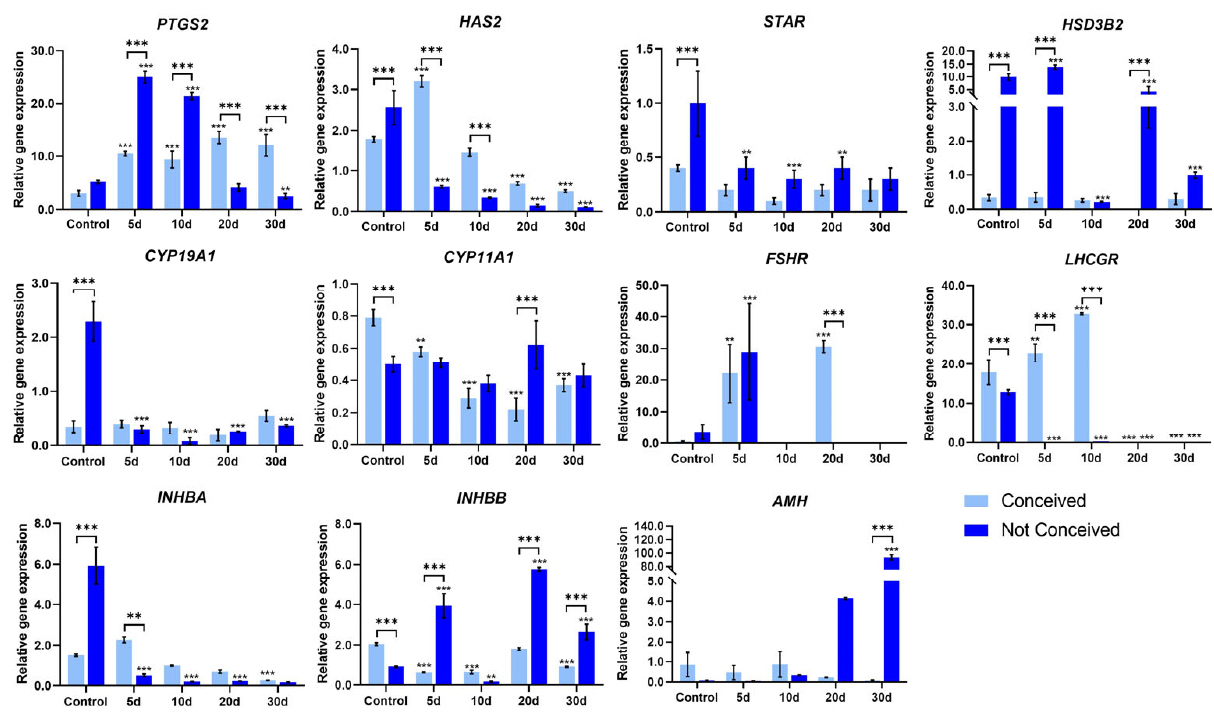
Figure 5. Real ‐ time PCR analysis of genes related to FSH response in human follicular fluid stromal cells. Results are presented as mean ± standard deviation. In the conceived group, n = 3; in the not-conceived group, n = 3. Statistical significance calculated using the two-way ANOVA, p ≤ 0.01 (**); p ≤ 0.001 (***).